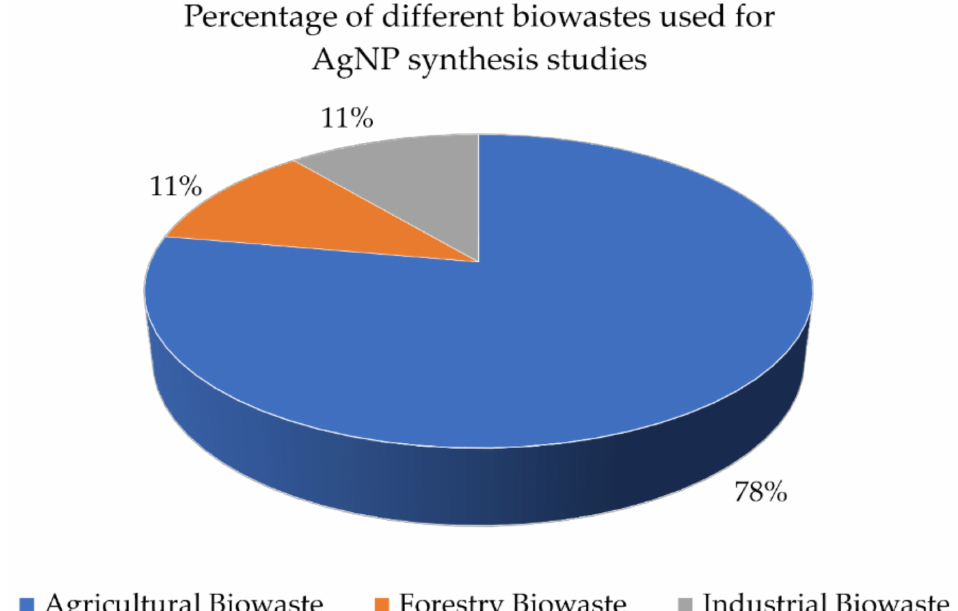
Figure 2. A pie chart visualizing the general dominance of prominent biowastes in the field of silver nanoparticle (AgNP)